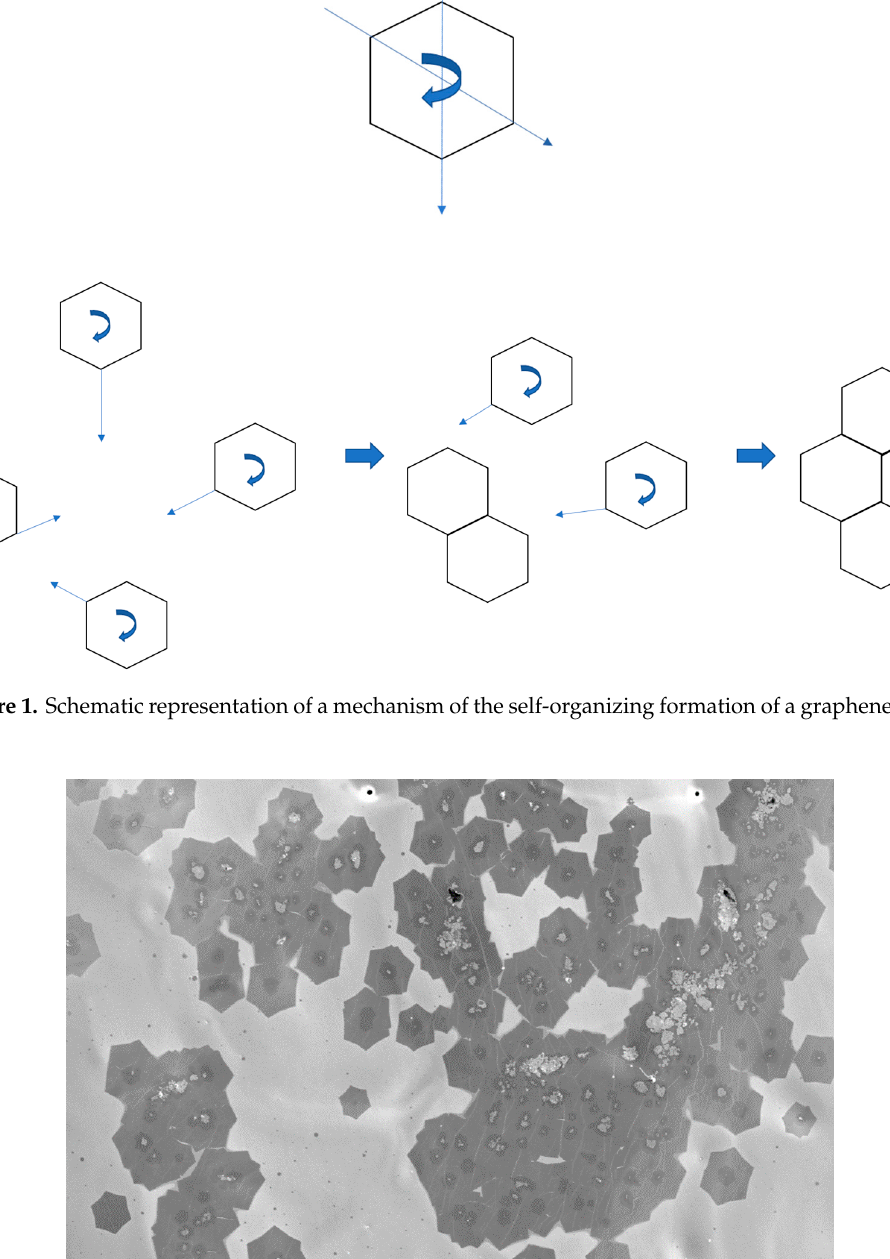
Figure 3. ( a ) SEM image of the foreign particle; and ( b ) EDS spectrum of a foreign particle. Based on the EDS spectrum (Figure 3), the particle was identified as ceramics, most probably derived from the ceramic furnace components. As mentioned previously, these particles behave like active sites, therefore, graphene nuclei grown on the impurities often create aggregates, that prevent the movement of arising flakes (Figure 2). On the other hand, a clean surface provides ideal conditions for the growth of single individual domains, which is shown in Figure 4. Moreover, the lower the nucleation rate, the higher the tendency for quasi-monocrystalline assemblance observed. This phenomenon is only possible for growth on a liquid surface, which is atomically smooth and does not block the domains from rotating and moving towards each other allowing the self-alignment